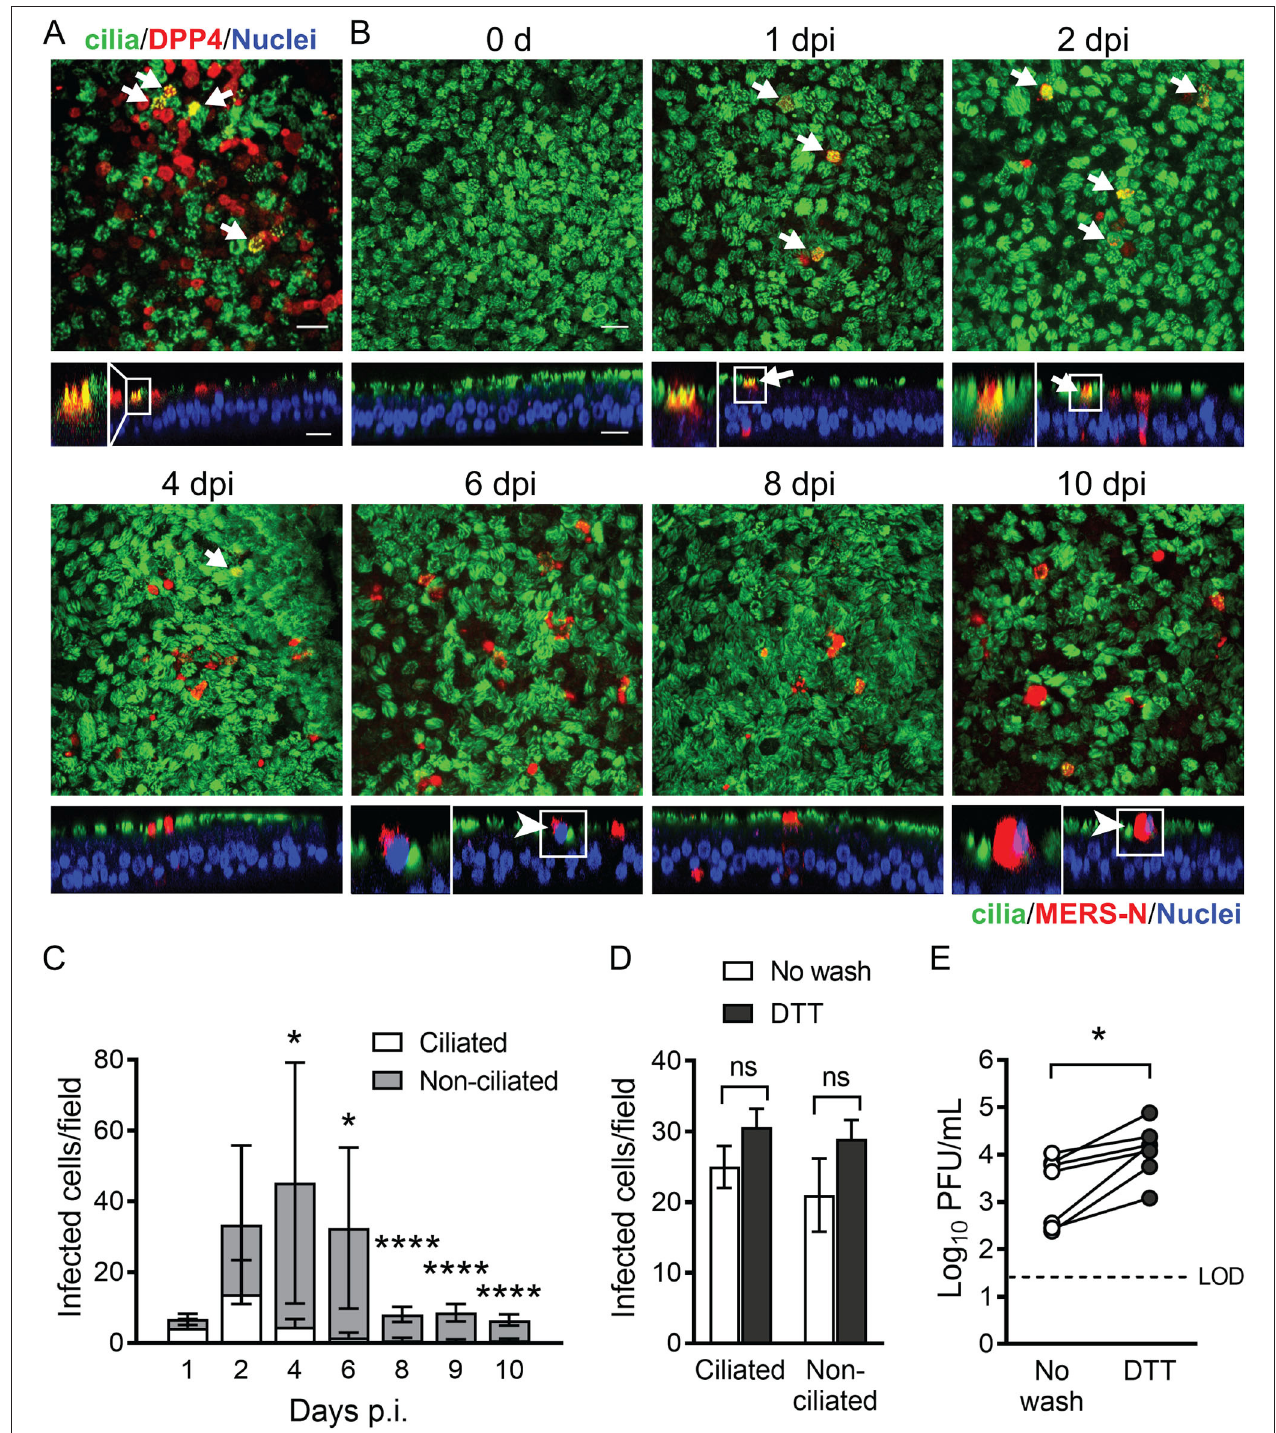
FIGURE 1 | MERS-CoV infection and spread in human airway epithelia. (A) DPP4 distribution in HAE demonstrated by immunofluorescence (DPP4, red; nuclei, blue). Ciliated cells are indicated by positivity for acetylated tubulin (green). DPP4 is expressed on the apical surface of nonciliated and occasional ciliated cells (yellow; white arrows, inset). Scale bar = 20 µ m. (B) HAE were infected with MERS-CoV (MOI = 0.1) from the apical surface. At the indicated time points, cells were fixed and immunostained for viral antigen (N protein, red) and cilia (acetylated α -tubulin, green), followed by DAPI staining of nuclei (blue). White arrows indicate infected ciliated cells. Arrowheads denote infected cells on top of apical surface of the epithelium. Scale bar = 20 µ m. (C) The number of infected ciliated and non-ciliated cells per 40X field at the indicated time points post infection were determined by visual counting (3 fields/HAE donor x 3 donors). Data represent mean ± standard